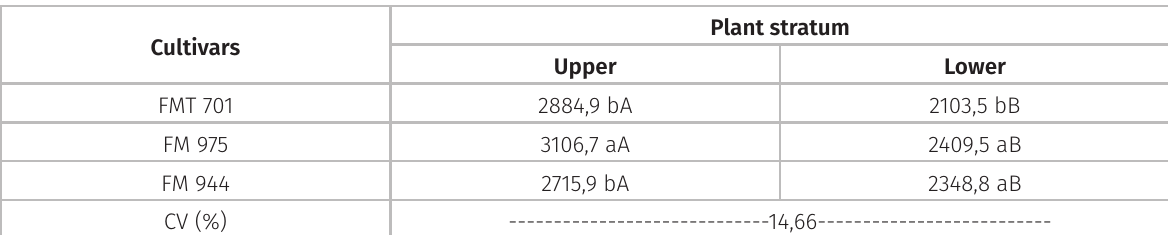
Table VII. Cotton seed yield (kg ha -1 ) in the upper and lower portion of the plants of three cultivars. Chapadão do Sul, MS. Crop season 2014/15.